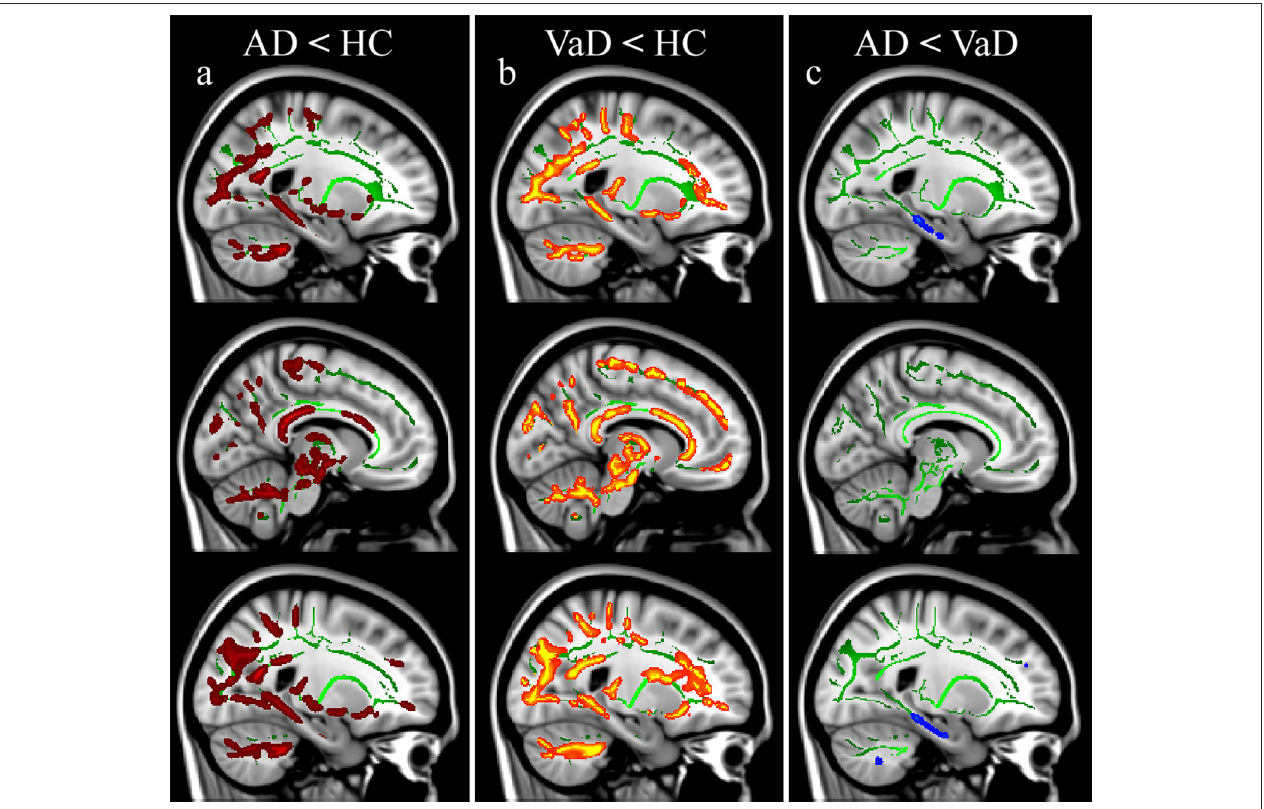
FIGURE 1 | Fractional anisotropy (FA) alterations in patients. Significance was set at p < 0.01 TFCE corrected for multiple comparisons. All results are overlaid onto the MNI 152 template and are shown as sagittal slices. Top row: left hemisphere (x = − 22mm). Middle row: medial view (x = − 9mm). Bottom row: right hemisphere (x = 23mm). FA reductions are reported in: (a) AD vs. HC, (b) VaD vs. HC, (c) AD vs.